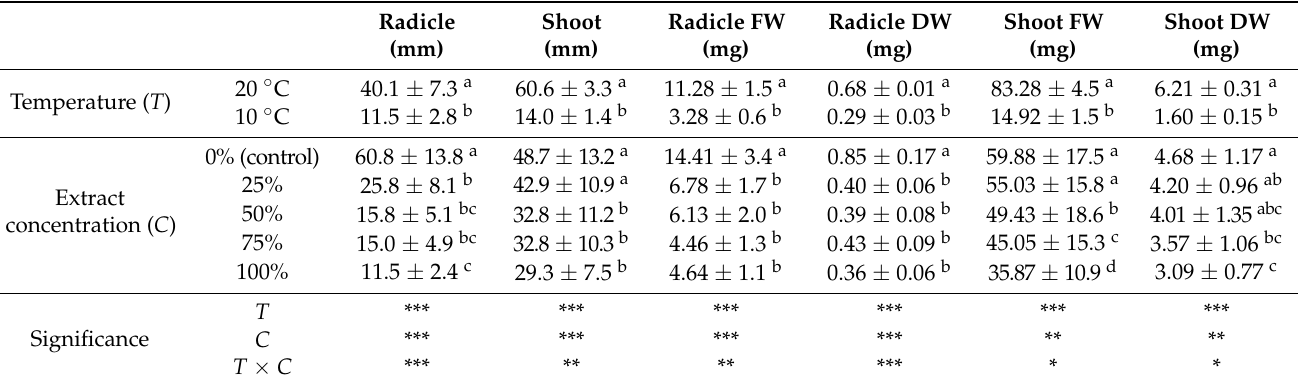
Table 7. Main effects of temperature and hemp leaf extract concentrations on radicle and shoot length, fresh (FW) and dry weight (DW), in barley cv.